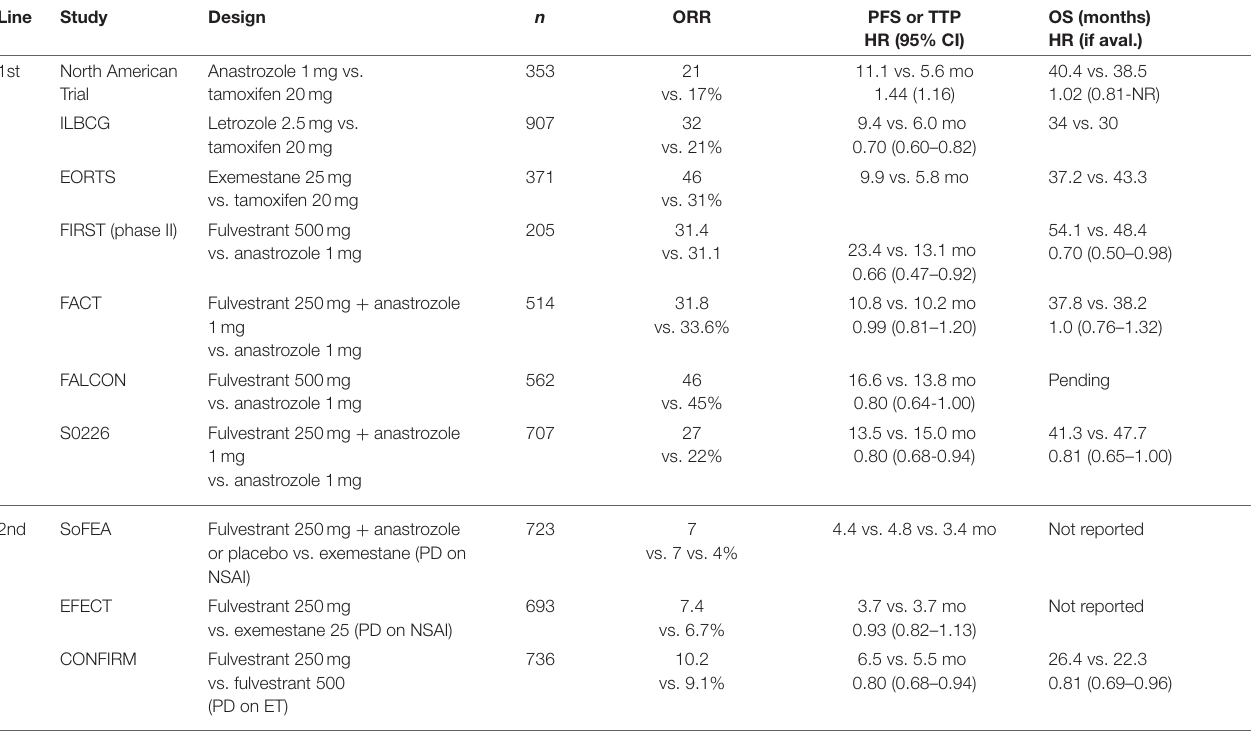
TABLE 1 | Summary of important phase III clinical trial results for endocrine therapy in metastatic HR positive, HER2 negative breast cancer.